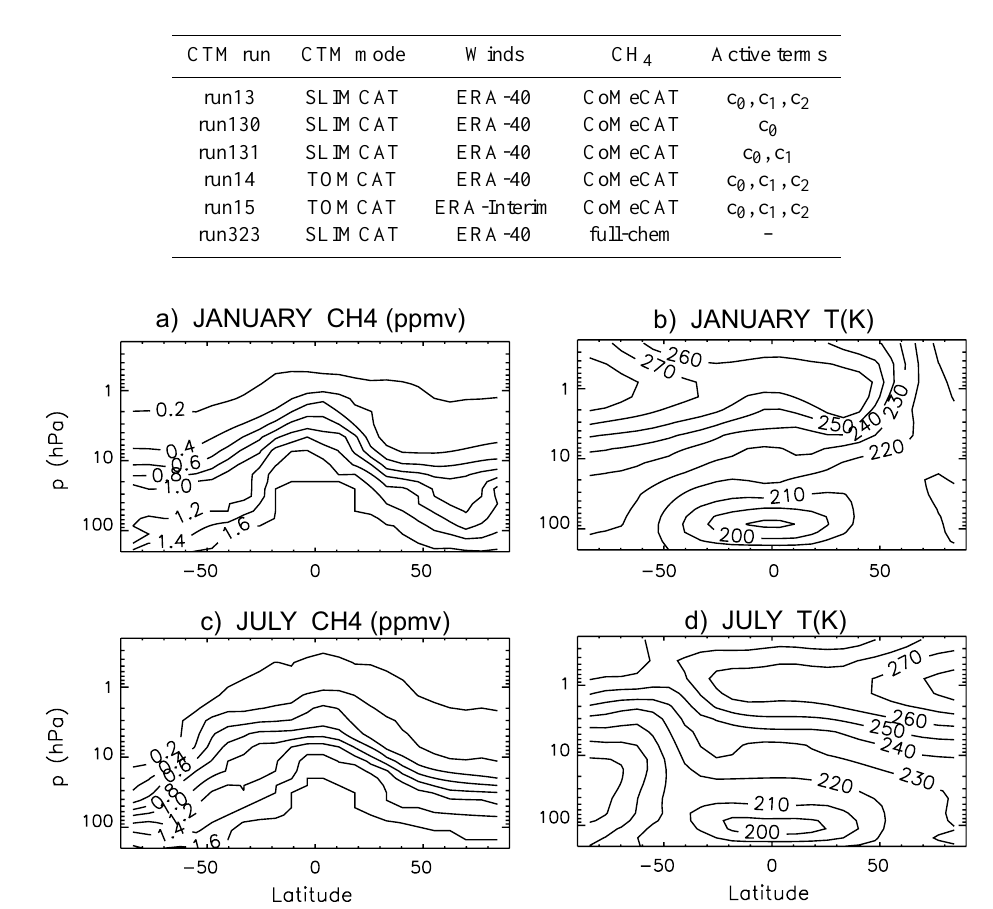
Fig. 1. Zonal mean of CoMeCAT [ CH 4 ] (ppmv) (left panels) and temperature T (K) (right panels) reference terms for January (top row) and July (bottom row) 2004. These reference terms come from the SLIMCAT CTM (see main text for details, Sect.